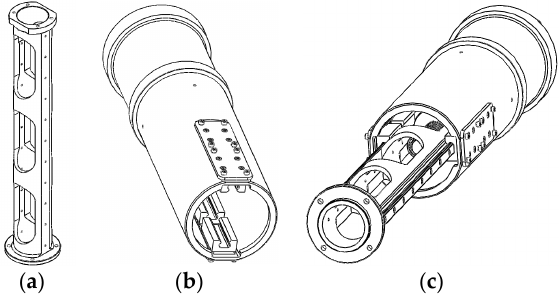
Figure 3. Improved cylinder guide pillar module: ( a ) cylinder guide pillar; ( b ) cylinder type support; ( c ) design structure diagram.